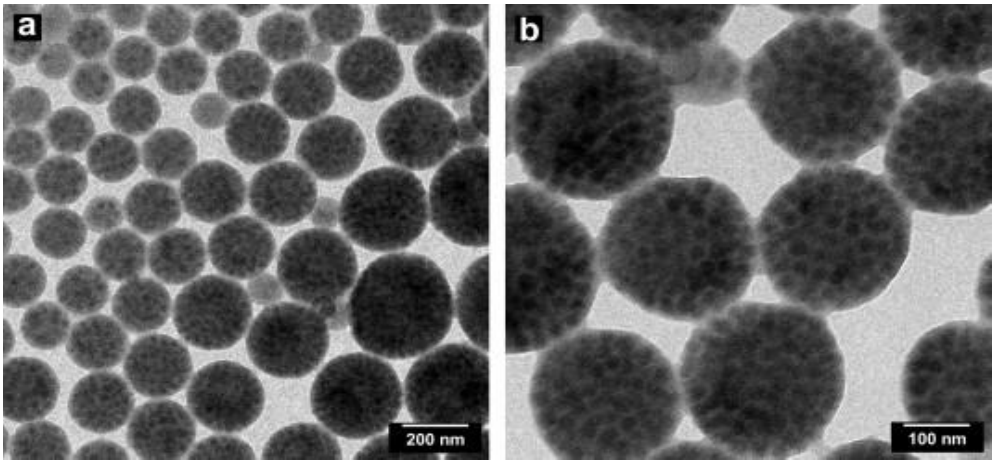
Figure 7. Morphology of hybrid particles with 40 wt% silica and good size distribution. Panels ( a ) and ( b ) show TEM images at different magnifications. Reprinted with permission from [57]. Copyright 2013,